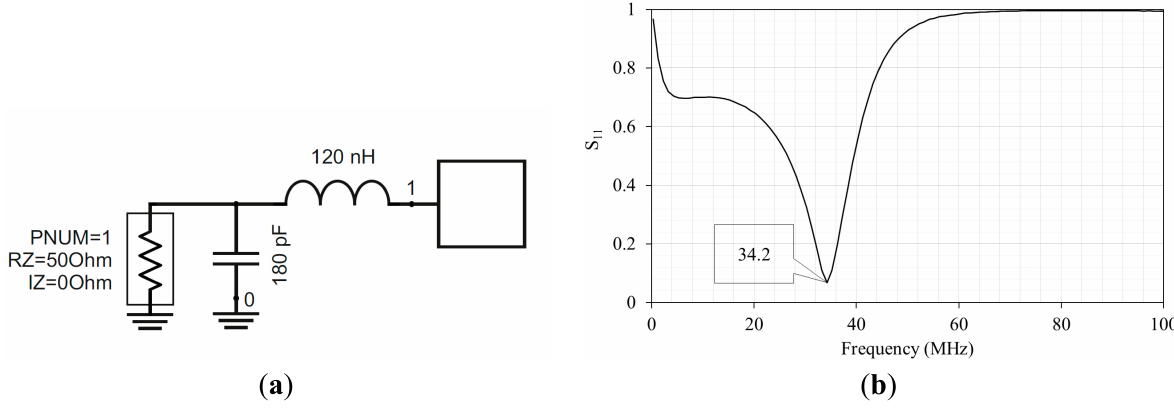
Figure 4. ( a ) Scheme of the electric matching circuit for the PVDF actuation. ( b ) VNA curve of the S parameter (reflection coefficient) measured for the 28 μm thickness PVDF 11 transducer after electric matching implementation. The minimum reflection peak is located at 34.2 MHz.